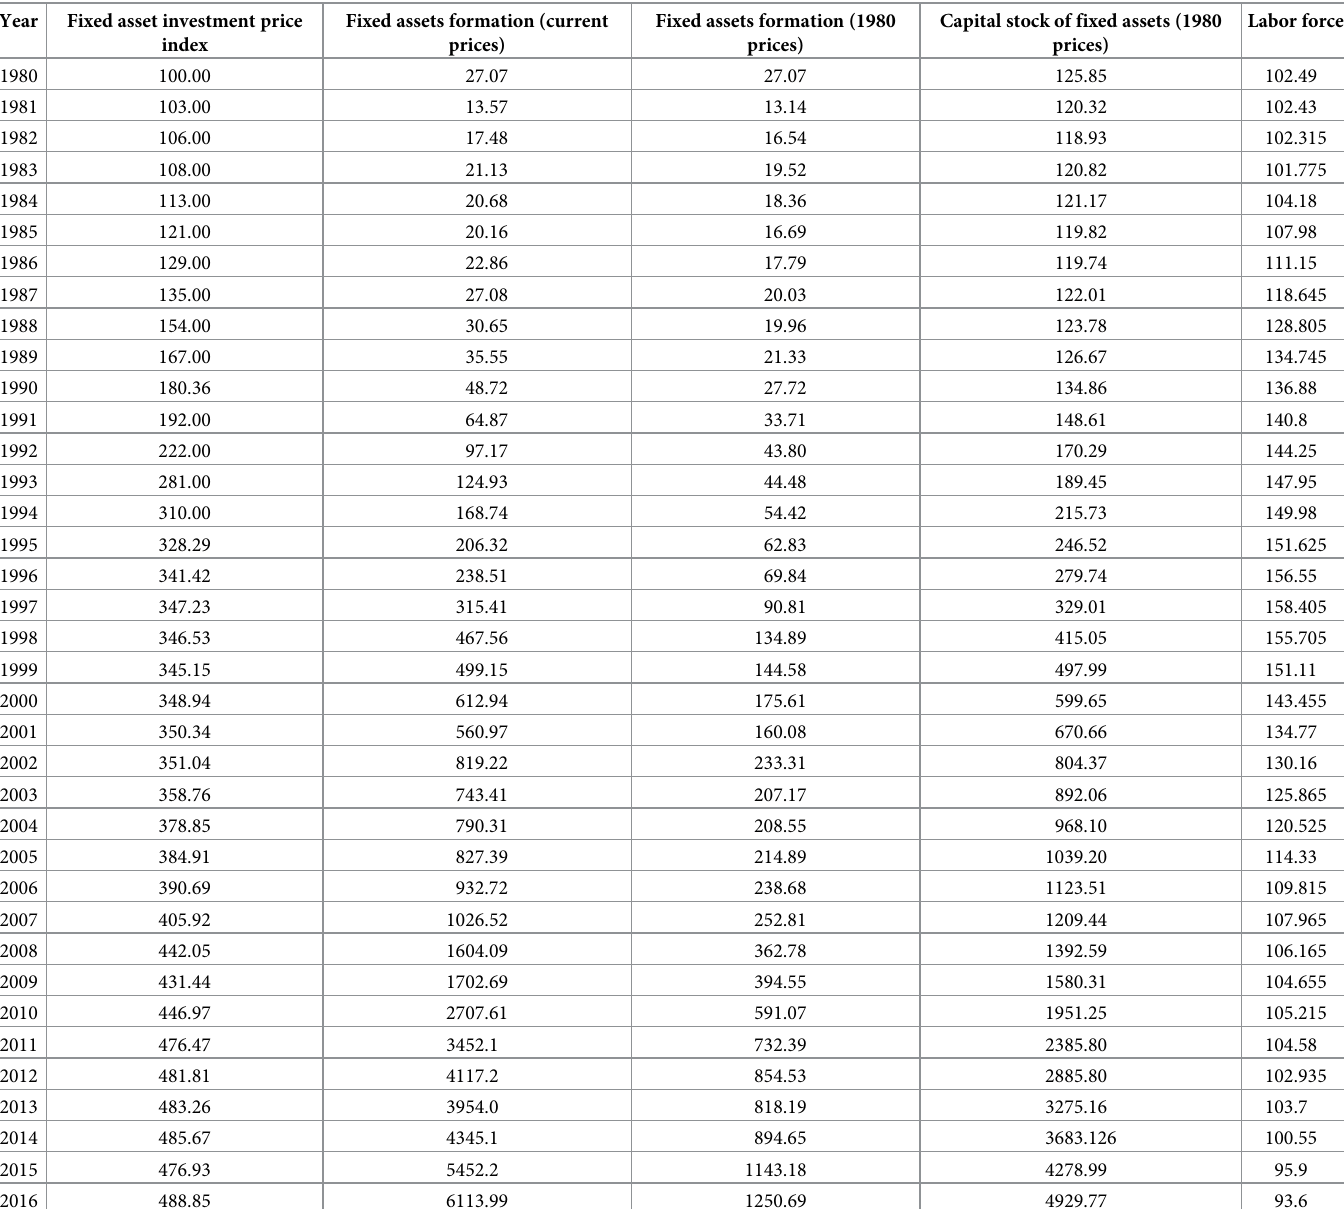
Table 2. Capital and labor input to the water conservancy system over